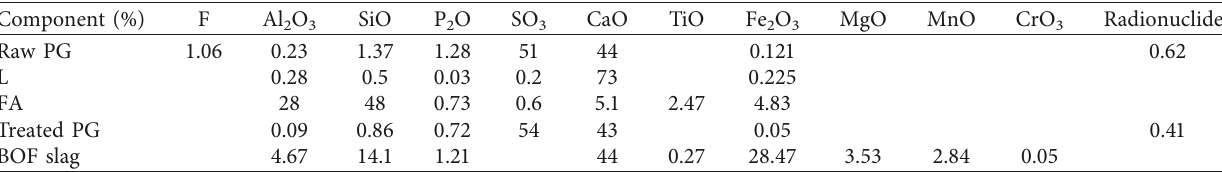
Table 1: Chemical composition of raw PG, lime, fly ash, treated PG, and BOF.